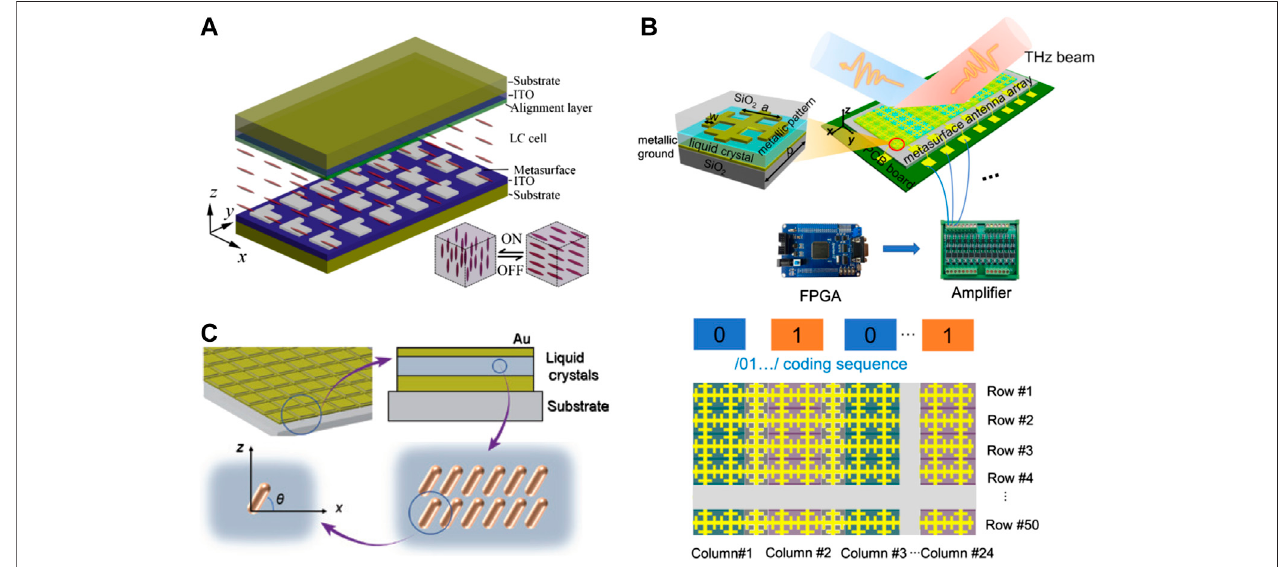
FIGURE 9 | Structures of LC background metamaterials. (A) Recon fi gurable spin-selectively multiband absorber based on LC chiral metasurface [160]. (B) Codeable LC metamaterial for controlling THz beam [159]. (C) Metal-LC-Metal platform with dynamic thermal camou fl age function [100]. Figure reproduced with permission from: (A) , © 2018, Optical Society of America (OSA); (B) , © 2020, AIP Publishing; (C) , © Walter de Gruyter GmbH